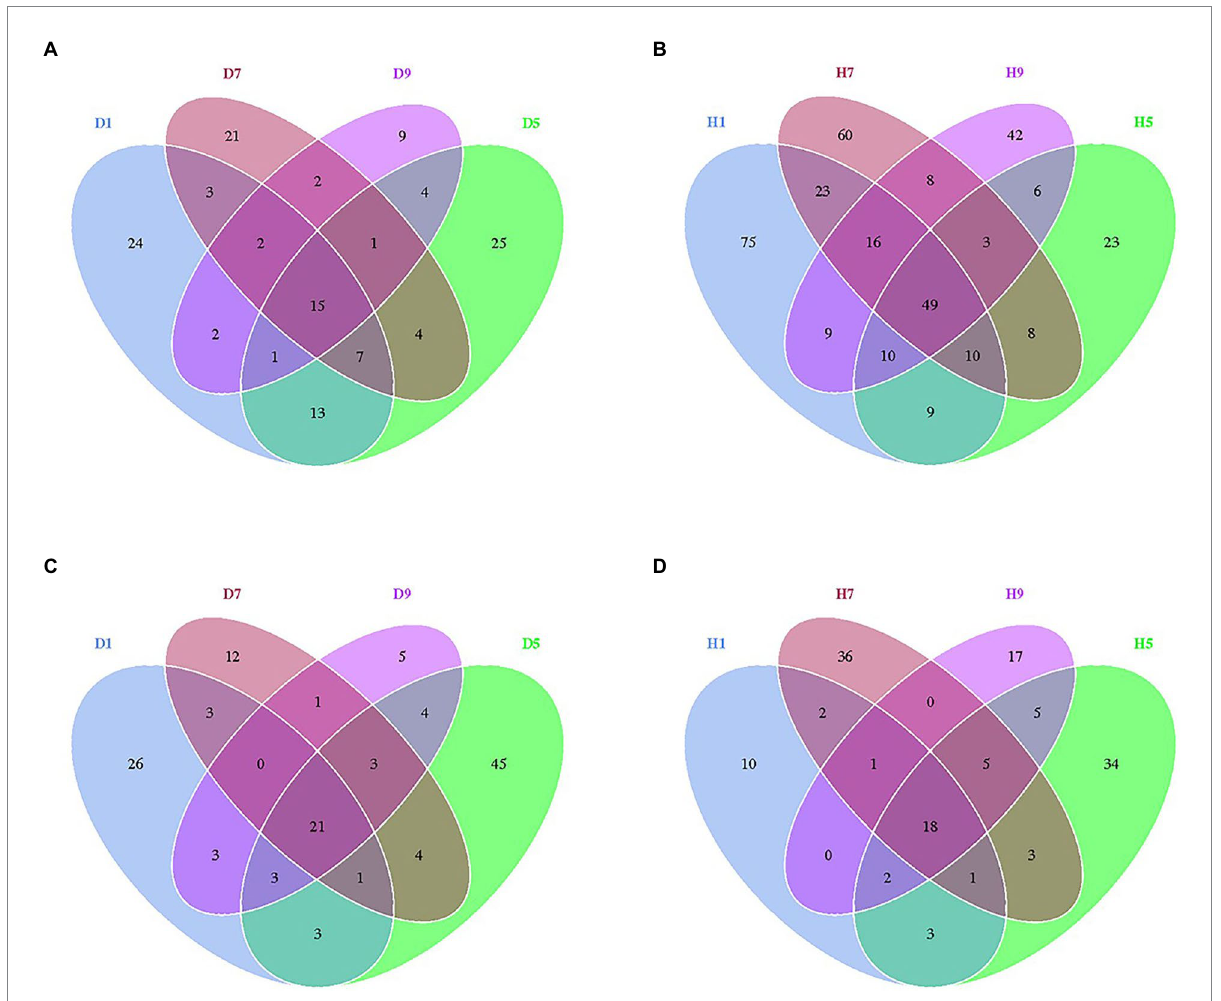
FIGURE 3 Venn diagram showing the number of fungal and bacterial OTUs observed in different groups at four different disease severity. Fungal Venn diagram in diseased (A) and healthy (B) groups at four different disease severities. Bacterial Venn diagram in diseased (C) and healthy (D) groups at four different disease severities. Numbers in the overlapping region indicated unique OTUs for two or three samples. Numbers in the non- overlapping regions indicated unique OTUs for the